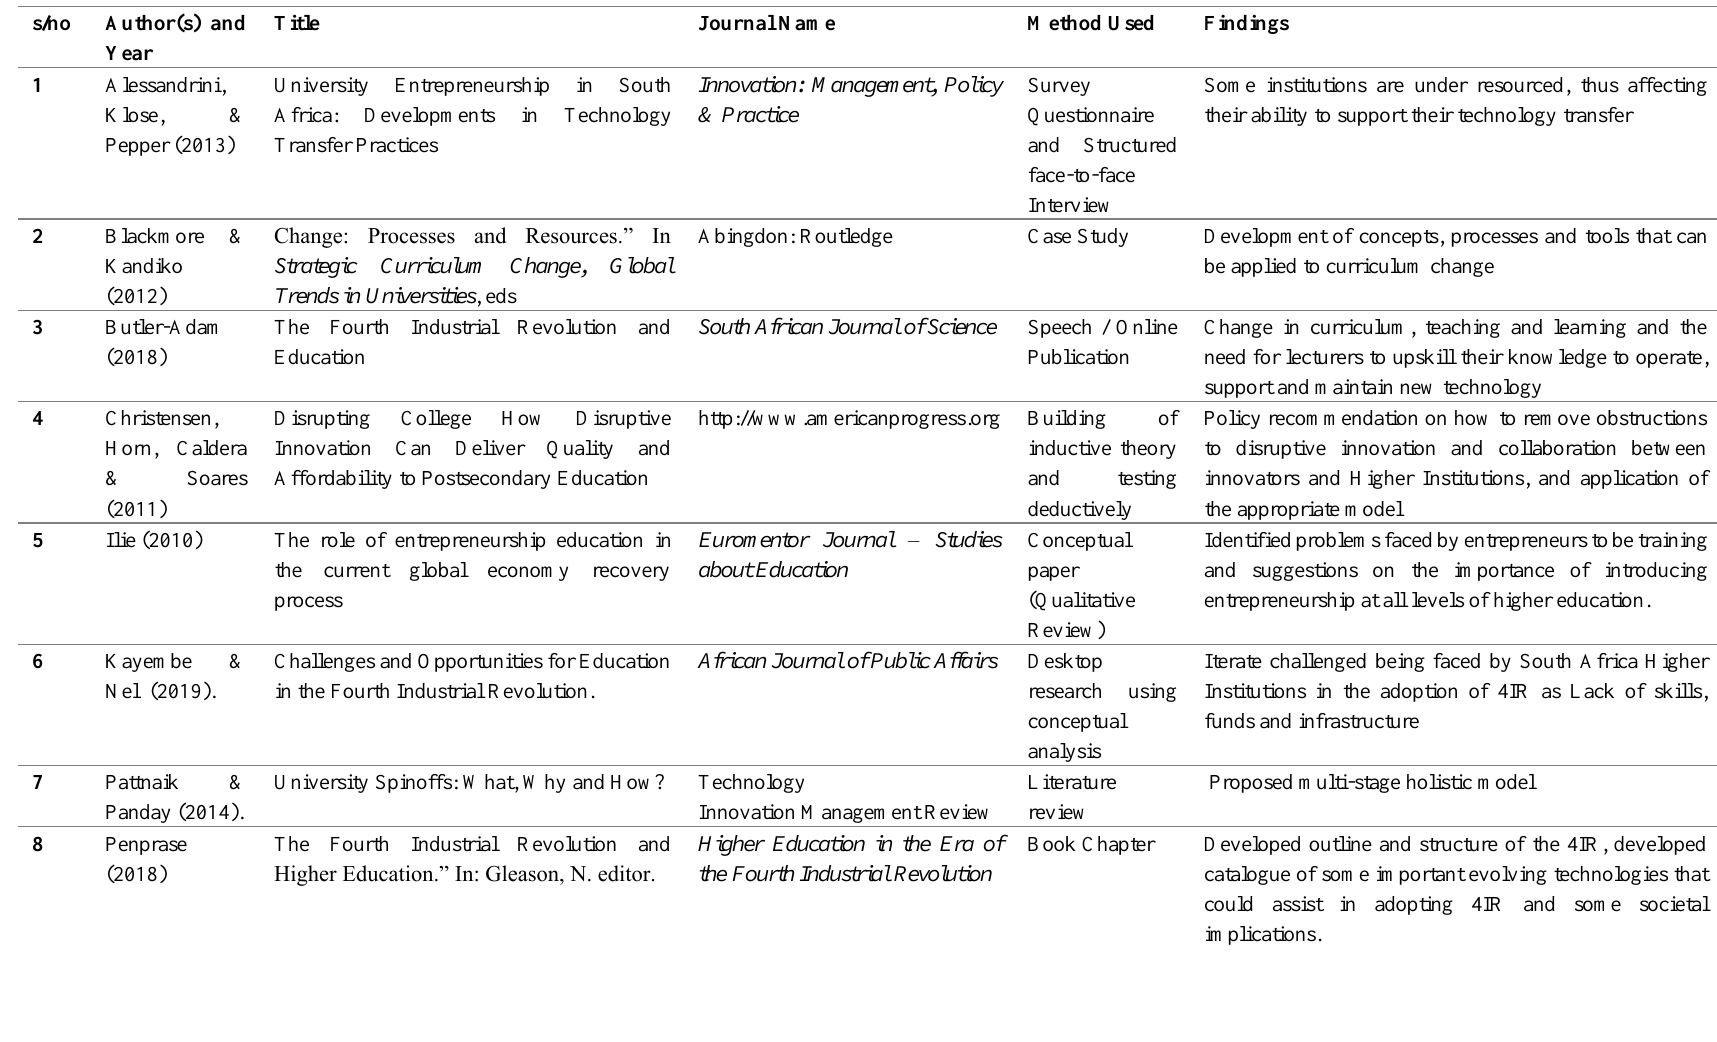
Table 1: Summary of related studies in